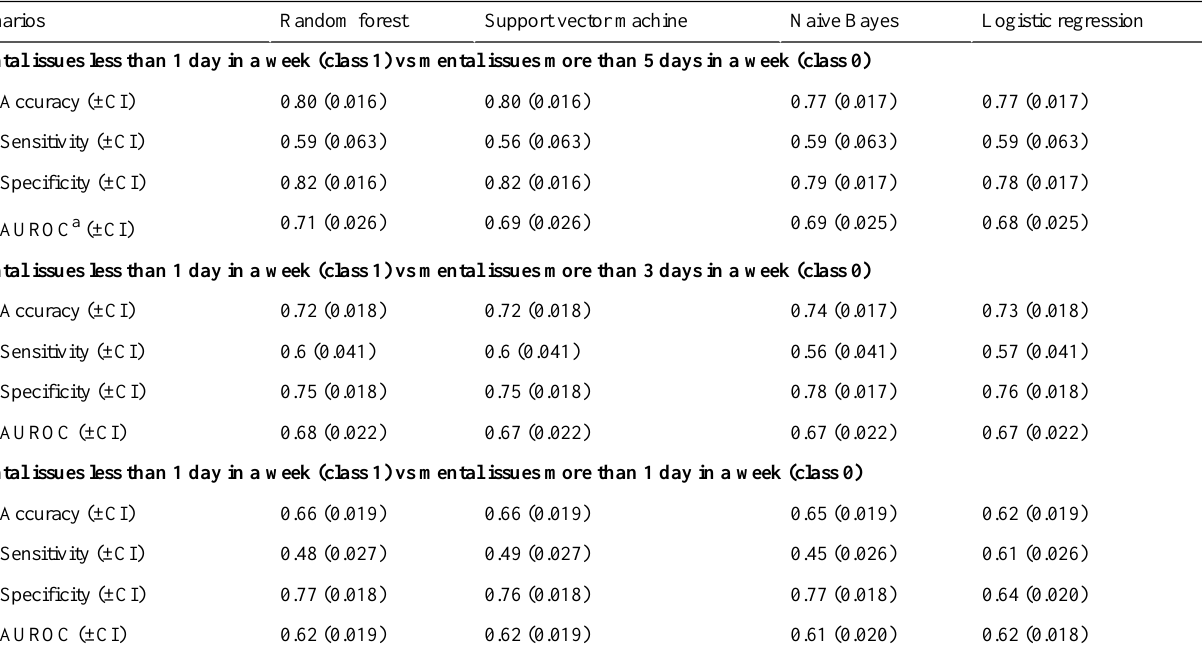
Table 1. Model performance indicators of the supervised model for prediction of